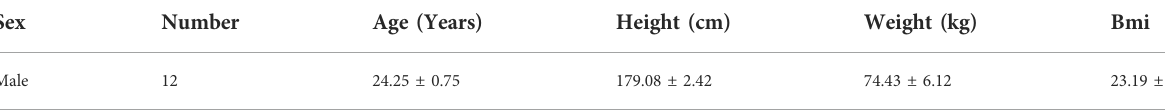
TABLE 1 Basic information of participants (mean±SD).